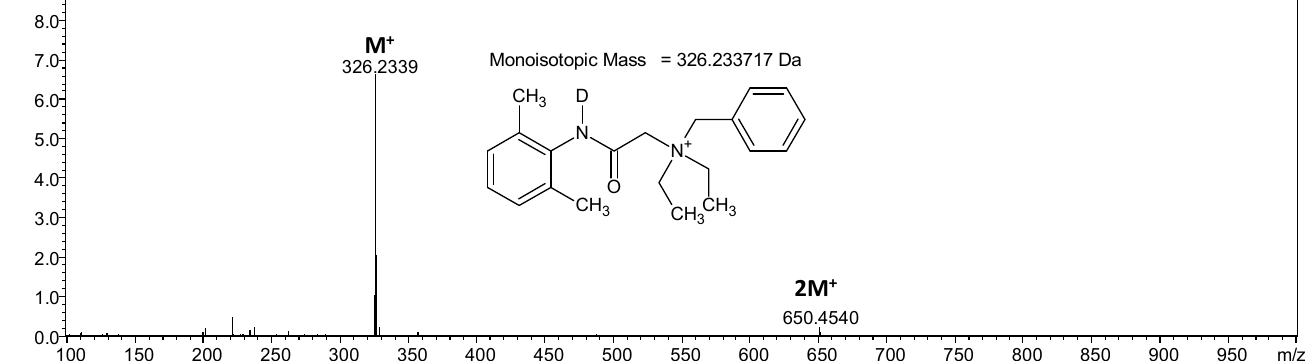
Figure 4. ESI-MS spectrum of denatonium cation after hydrogen-deuterium exchange of amide hydrogen in the positive ion mode. m / z range from 50 to 1000.